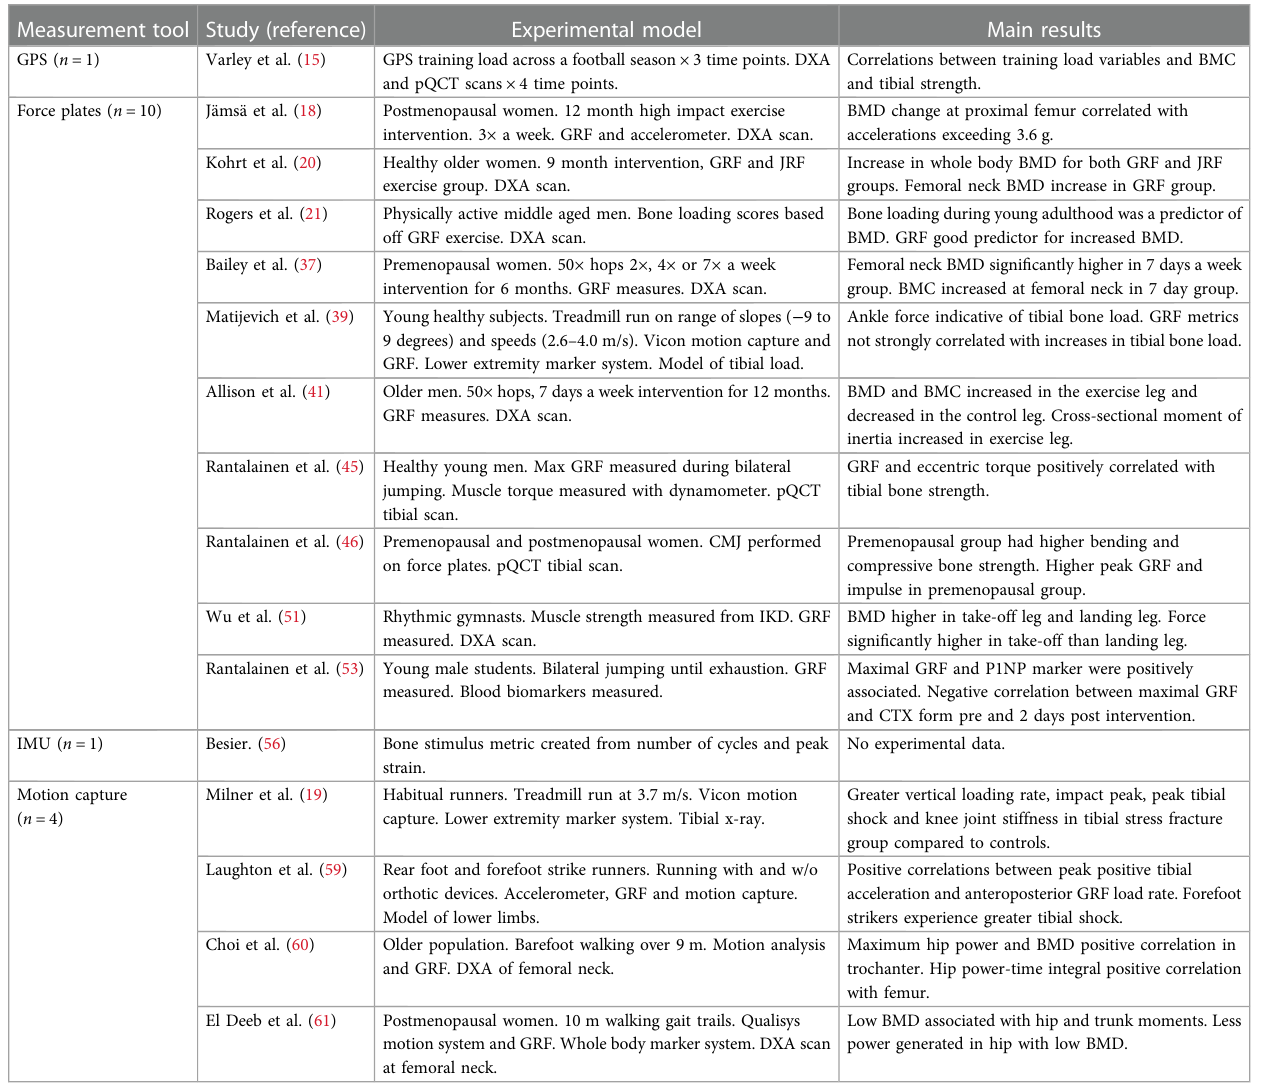
TABLE 3 Articles included in narrative review ( n